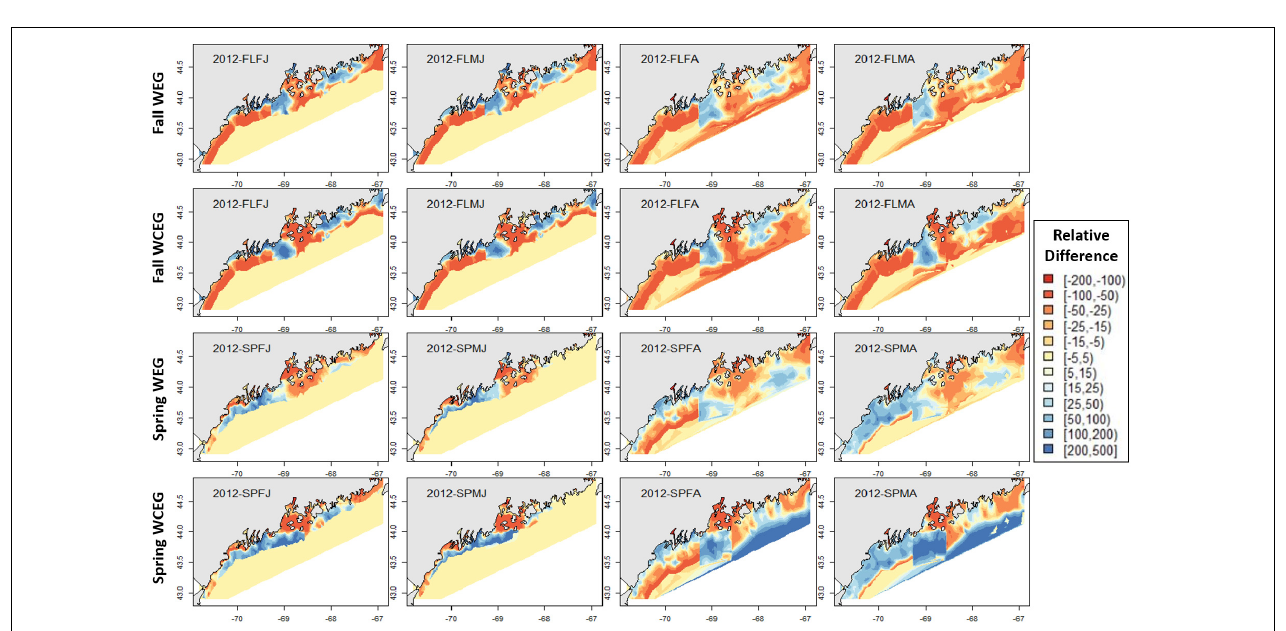
FIGURE 9 | 2012 American lobster relative differences in model abundance estimates. See Figure 8 for figure details.